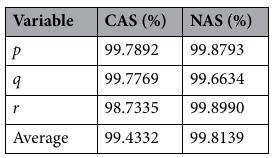
Table 3. The fitness of rotational states of UAV.